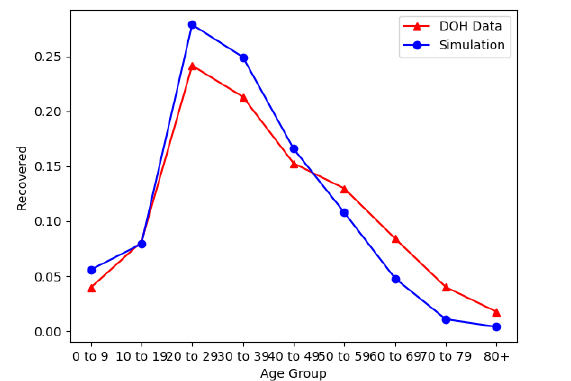
Figure 2. Validation of the recovery age distributions for the no vaccination